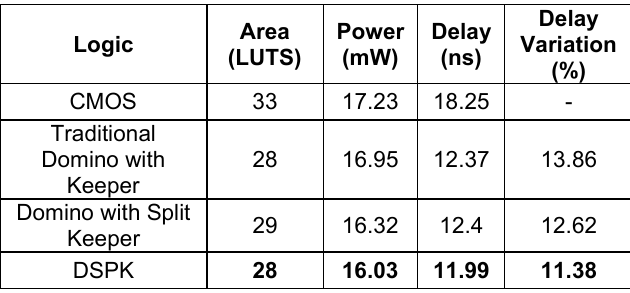
Table 5. Circuit Analysed: NOR4